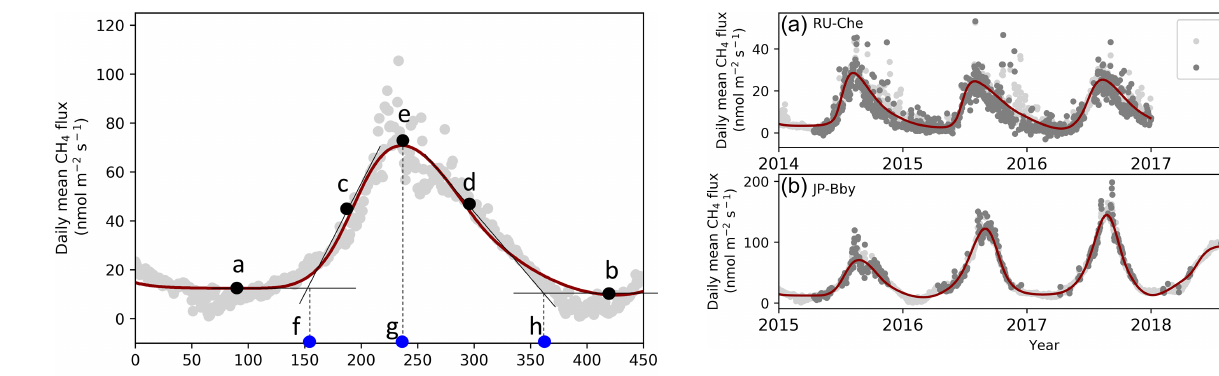
Figure 2. Examples of TIMESAT fits for two FLUXNET-CH 4 sites, (a) RU-Che and (b) JP-Bby. Methane (CH 4 ) flux data showing daily average flux tower data, with several high outliers excluded to improve the plot (dark gray), gap-filled values (light gray), and TIMESAT-fitted curve (dark red line) for sites JP-Bby and RU-Che. TIMESAT captures the size and shape of peaks (note different scale on y axes). CH 4 =